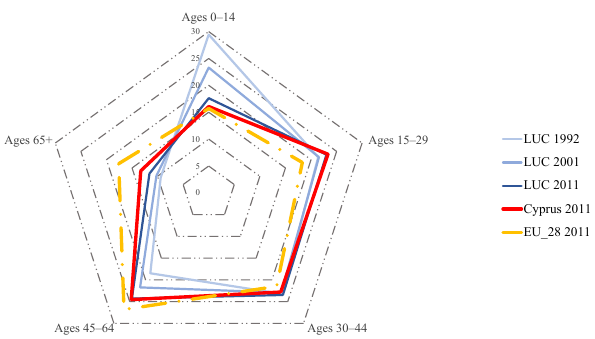
Figure 3. Age structure comparing EU-27, Cyprus and LUC.